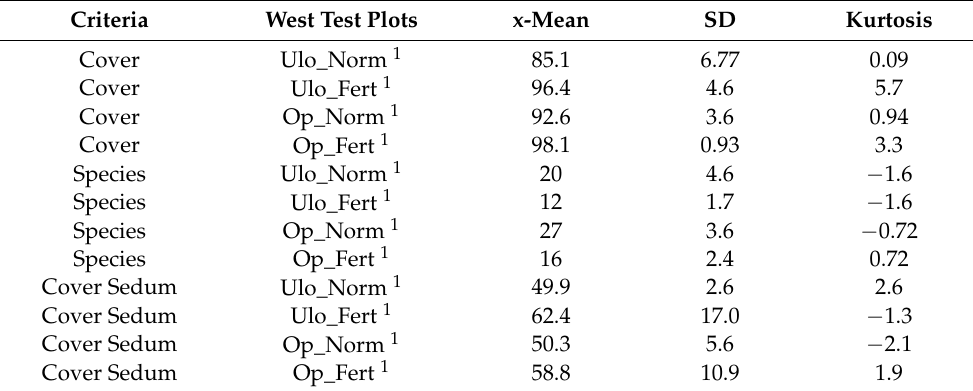
Table 12. Greening with vegetation mats, n = 9 years, from 2011 to 2020. The coverage and number of species for the test plots with fertilizer (Fert.) and without (Norm.) for the western position. Mean value, standard deviation, and